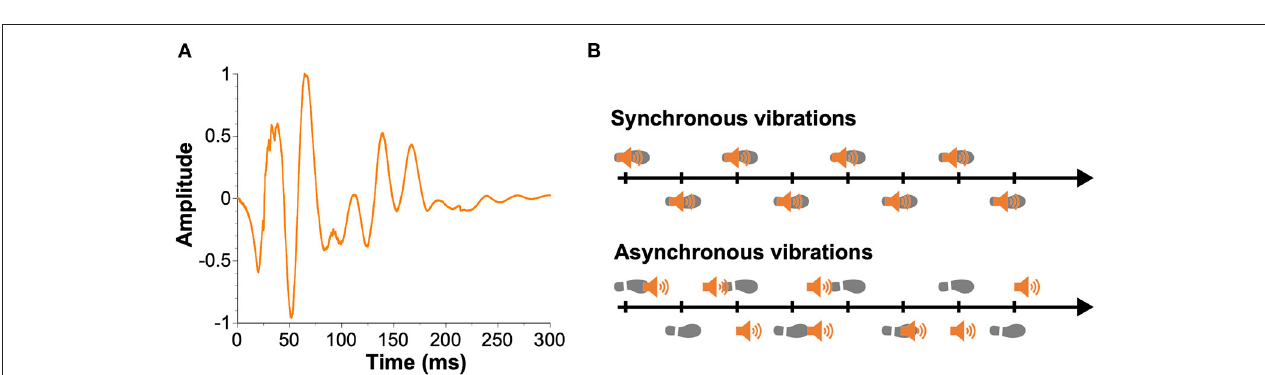
FIGURE 4 | Tactile stimulus. (A) Amplitude profile of vibration. (B) Synchronous and asynchronous vibration conditions.